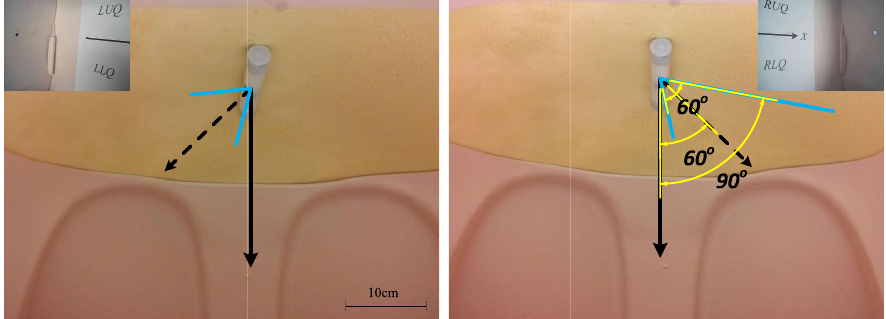
Figure 16. Tilt motion of the camera. A resultant tilt observation range angle of ± 90 ◦ was